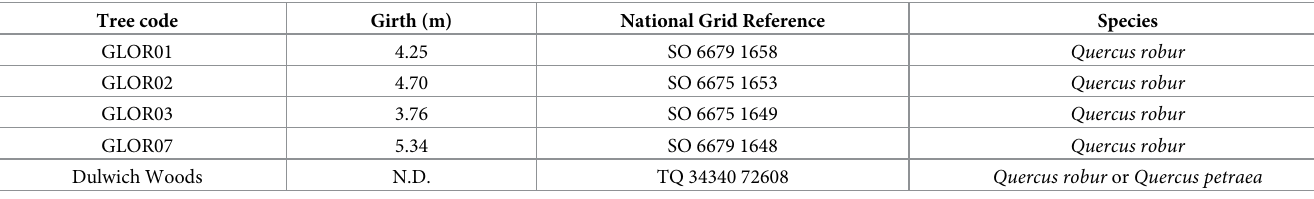
Table 1. Girth, National Grid Reference and species of the oak samples. Tree code